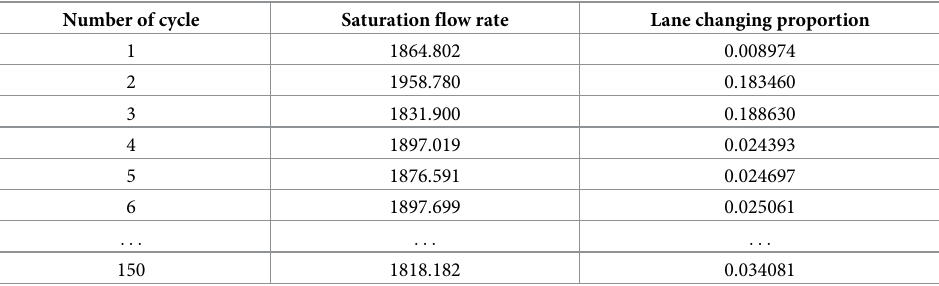
Table 6. Example of the recorded data of lane changing.